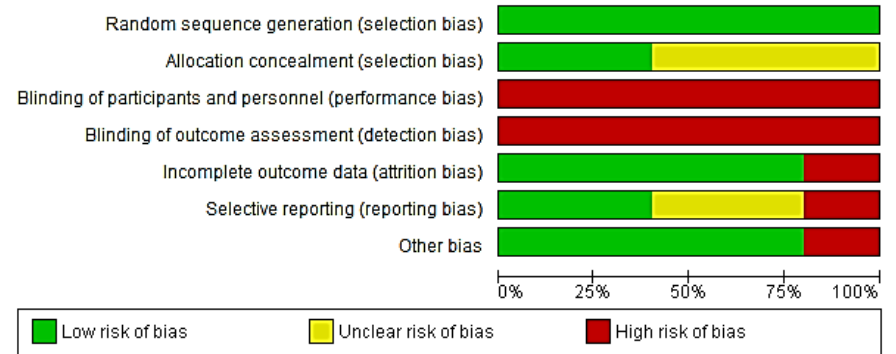
Figure 3. Risk of bias graph: a review of authors ’ judgments about each risk of bias item presented as percentages across all included studies [13,32 – 35].